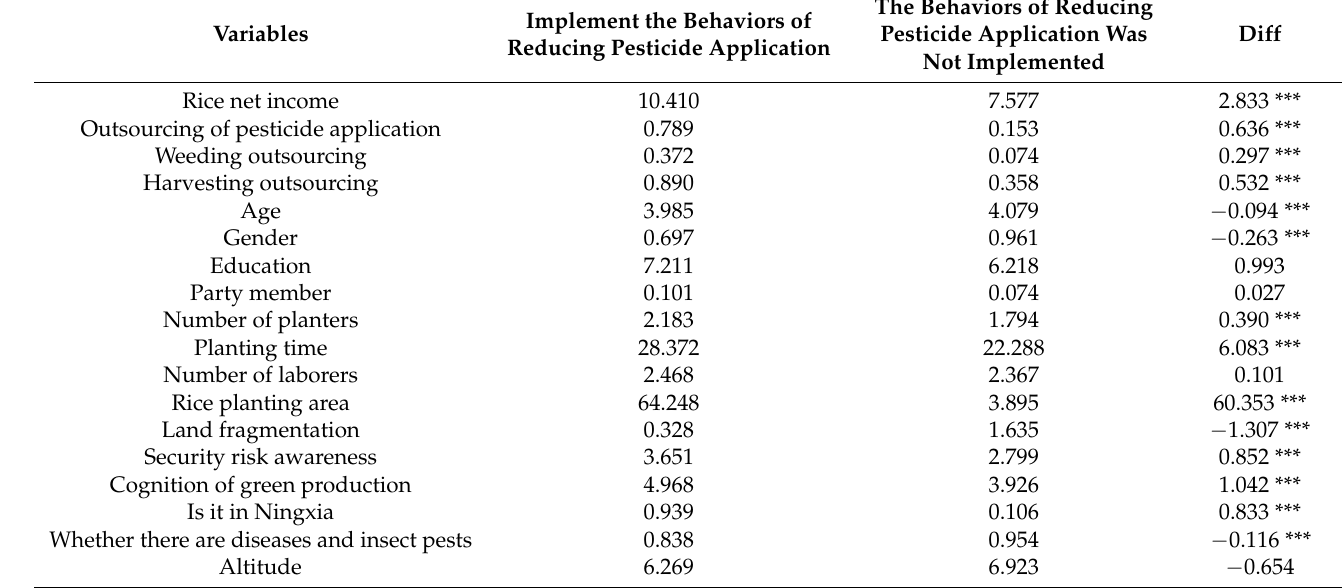
Table 2. The descriptive statistics and differences of rice farmers with and without reducing pesti- cide